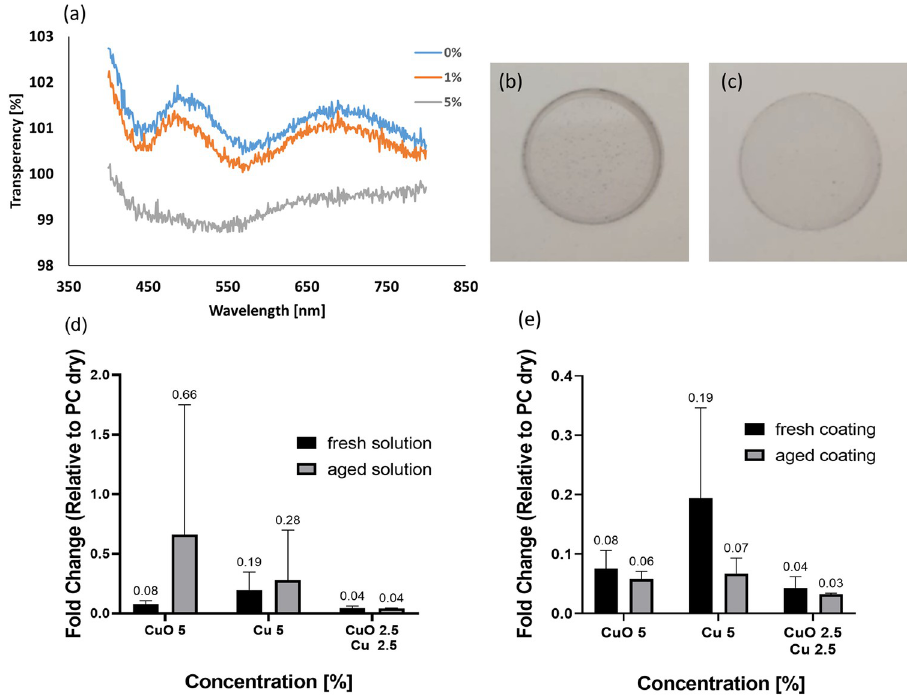
Fig 3. (a) Transparency test of samples of CuO with different concentrations. (b) optical image of PMMA with 10% CuO (c) optical image of PMMA with 5% CuO. (d-e) antiviral effect of freshly prepared or aged composite coatings (d) comparison between the fresh solution and aged solutions (e) comparison between fresh coatings and aged